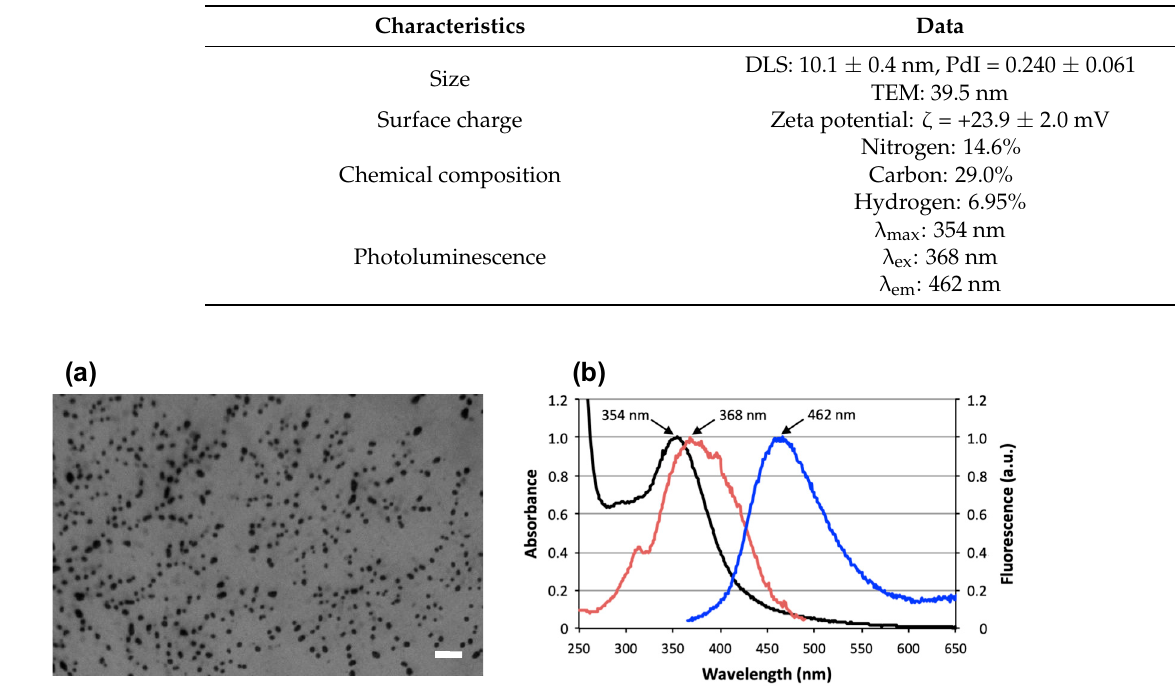
Figure 1. ( a ) Morphology of the bPEI600-based CDs as observed by TEM (scale bar = 200 nm). ( b ) Optical properties of the CDs: absorption (black), excitation (red), and emission (blue; excitation at 355 nm) spectra.